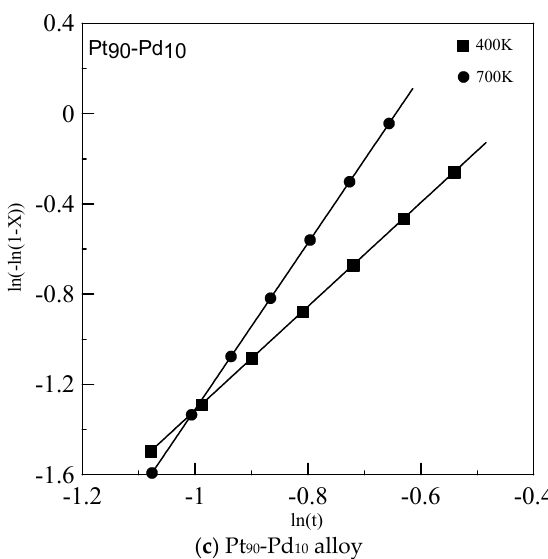
Figure 5. Fitting curves of ln( − ln(1 − x )) change with ln( t ) for different annealing temperatures. ( x is the volume fraction and t is the annealing time).